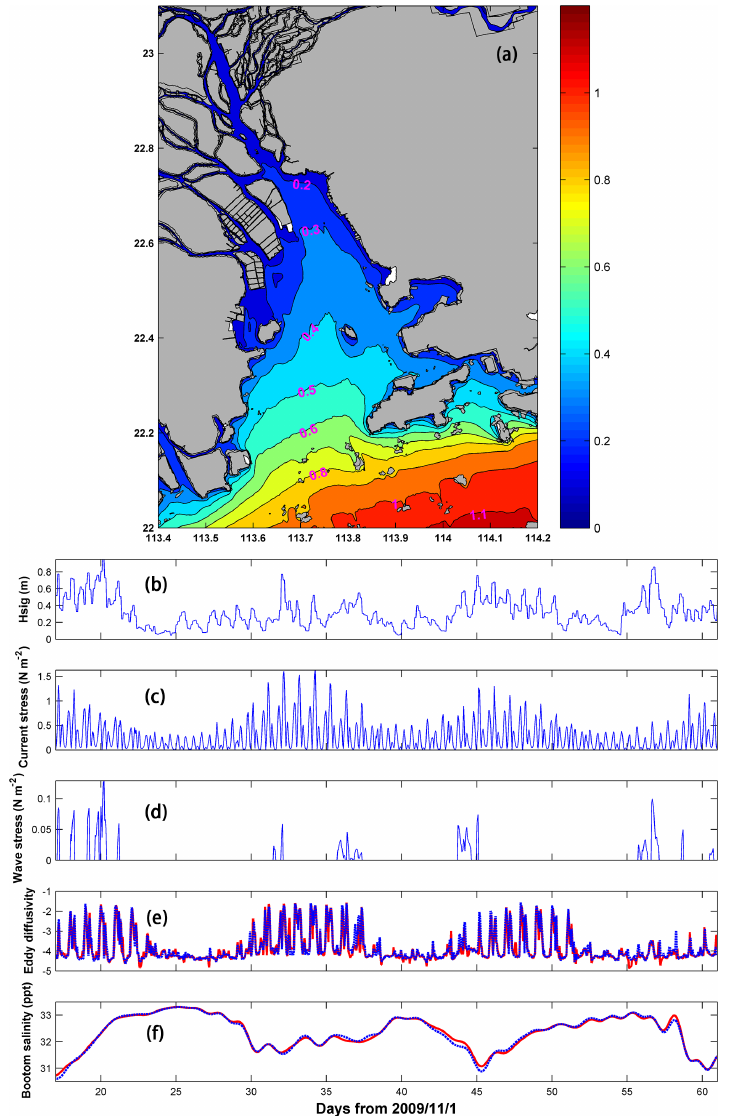
Figure 11. Panel (a) Spatial distribution of significant wave height (units: m) on Day 47; panel (b) time series of significant wave height at the selected station; panel (c) current-induced bottom stress; panel (d) wave-induced bottom stress; panel (e) vertically-averaged of the logarithm (log 10 ) of eddy diffusivity with waves (red solid line) and without waves (blue solid line). panel (f) Bottom salinity with waves (red solid line) and without waves (blue solid